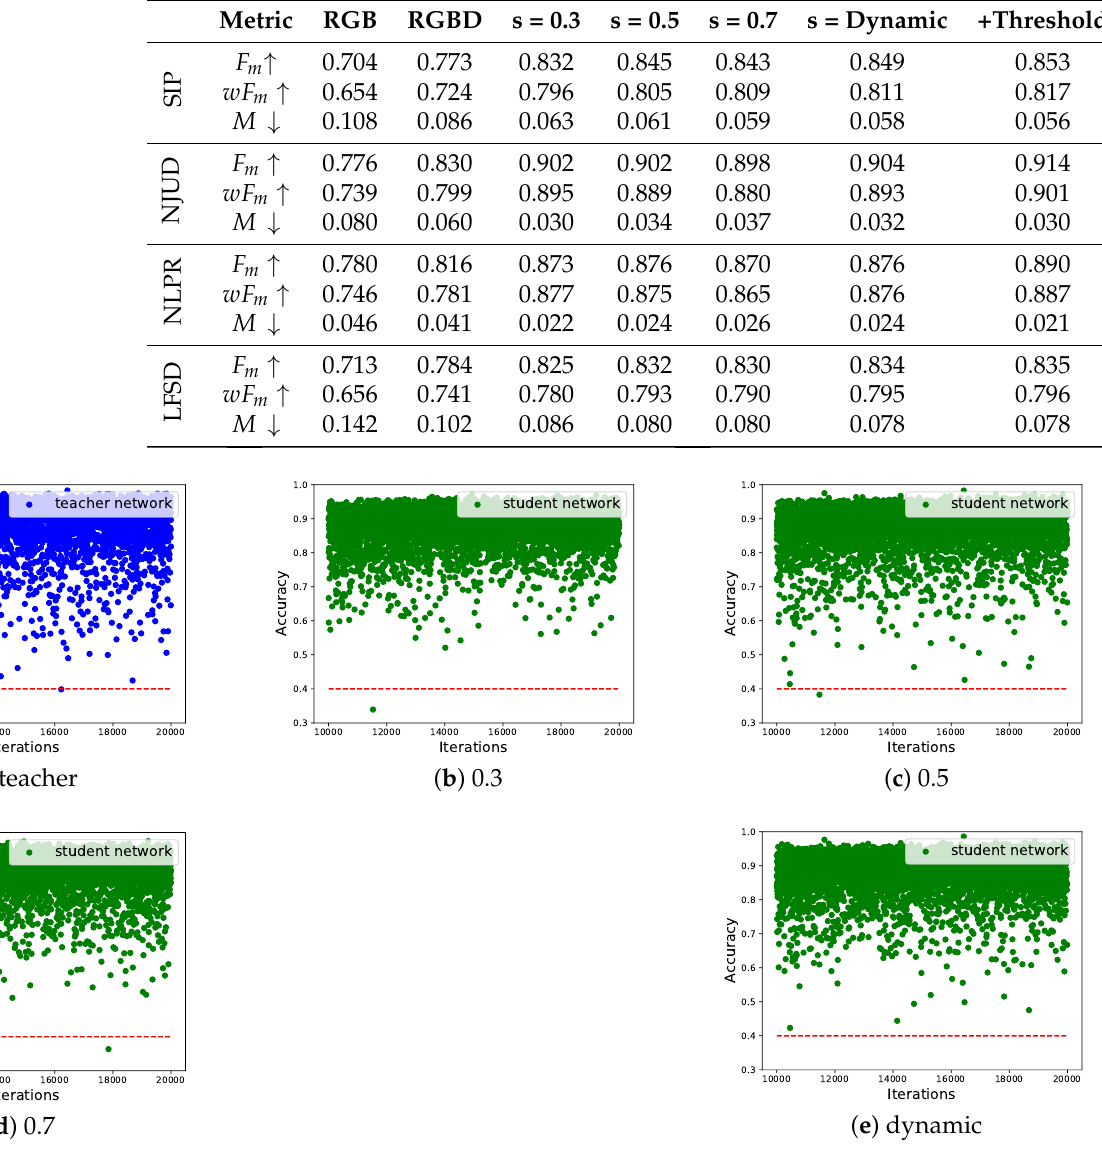
Figure 7. Teacher and student scatters with different distillation weights. We exhibit the last 10,000 training iterations and DKD shows better overall